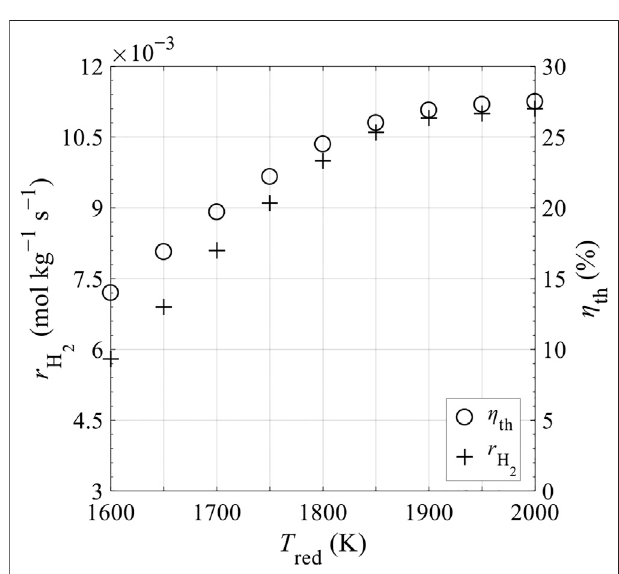
FIGURE 13 | Hydrogen production rate per kilogram of ceria, r H total solar-to-fuel ef fi ciency, η th , as a function of reduction temperature T red .